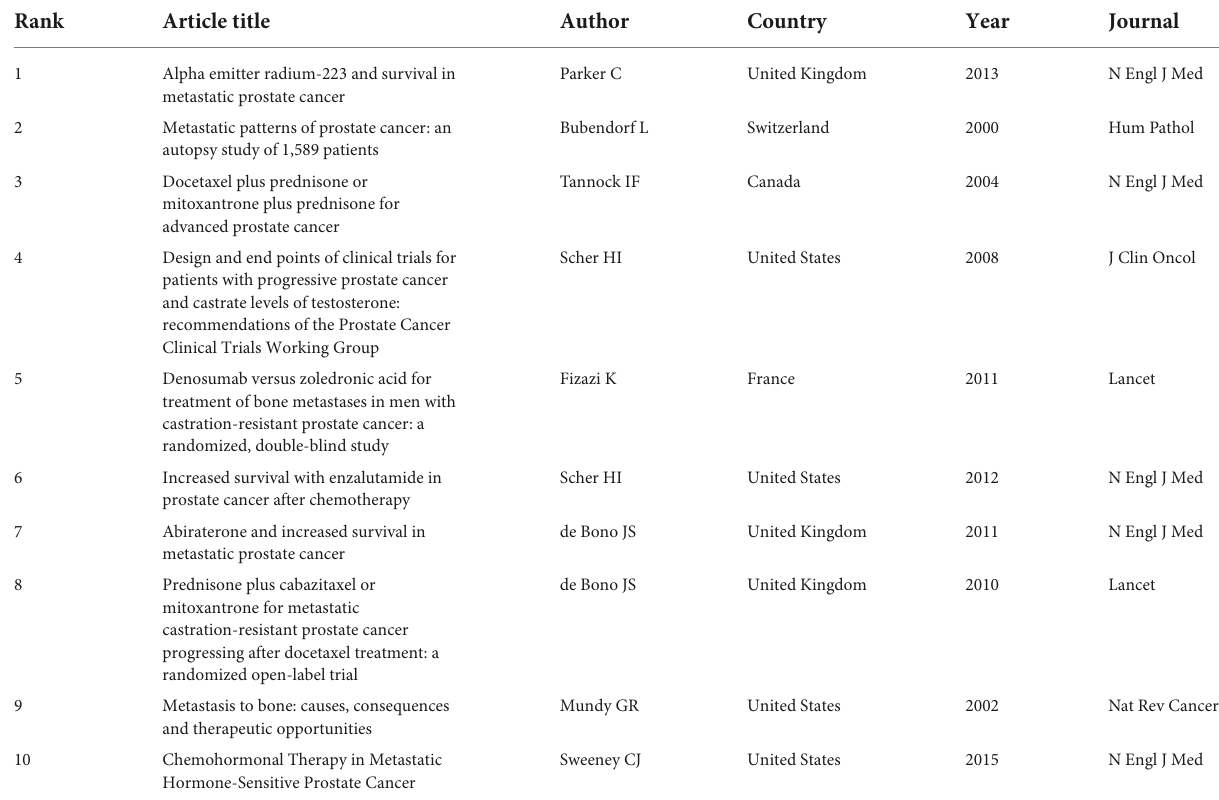
TABLE 4 The top 10 co-cited references related to PCa bone